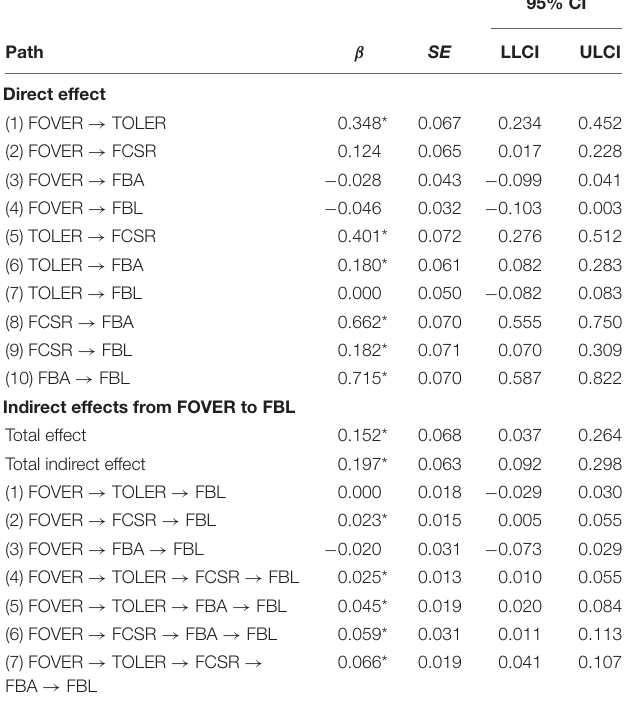
TABLE 5 | Model estimates for favorite league.